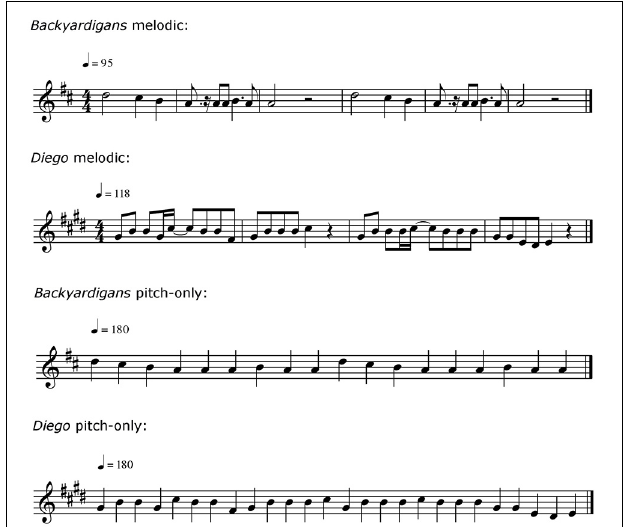
FIGURE 1 | Sample melodic and pitch-only versions of two of the test